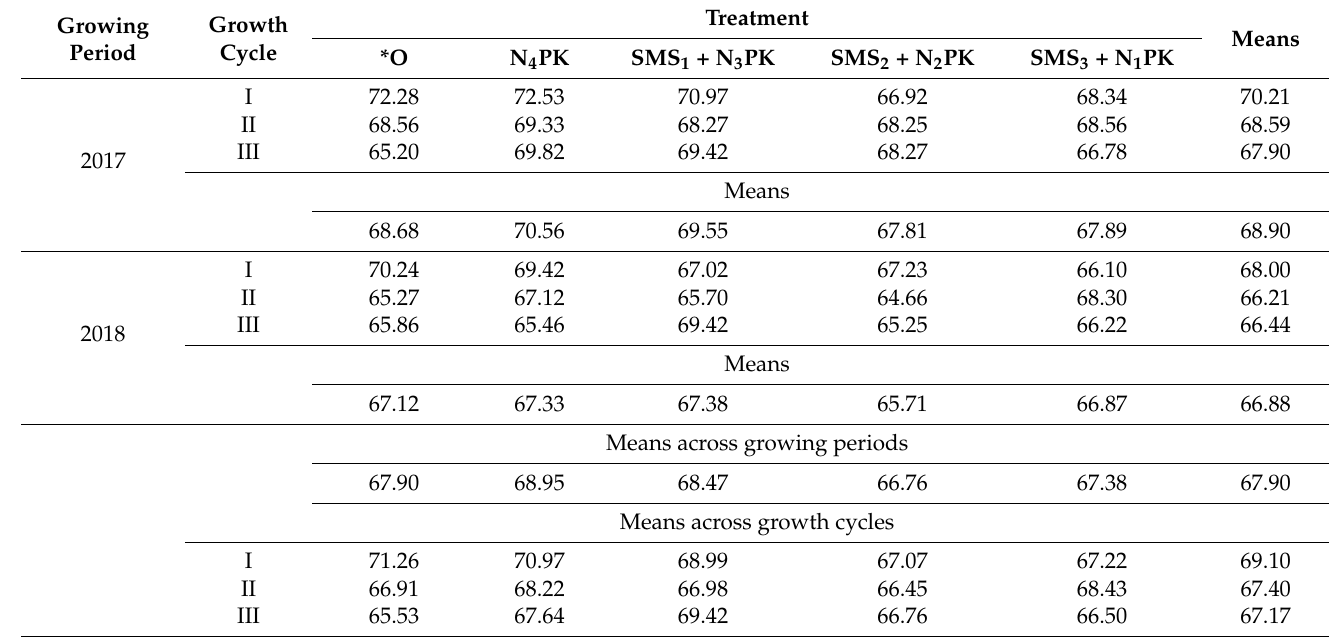
Table 6. The effect of fertilizer treatment, growing period and growth cycle on Festulolium braunii digestibility (%